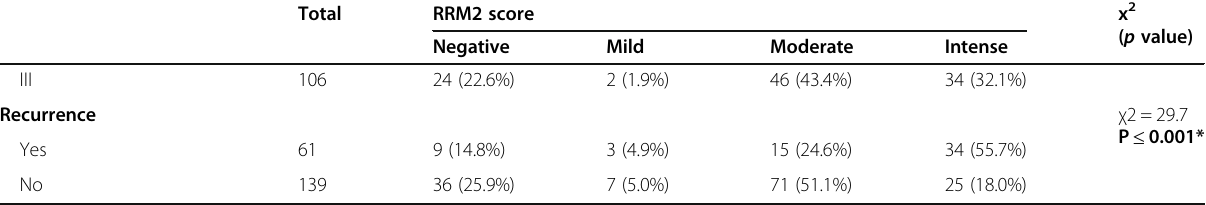
Table 2 Correlation between RRM2 protein expression and other clinicopathological variables (Continued)